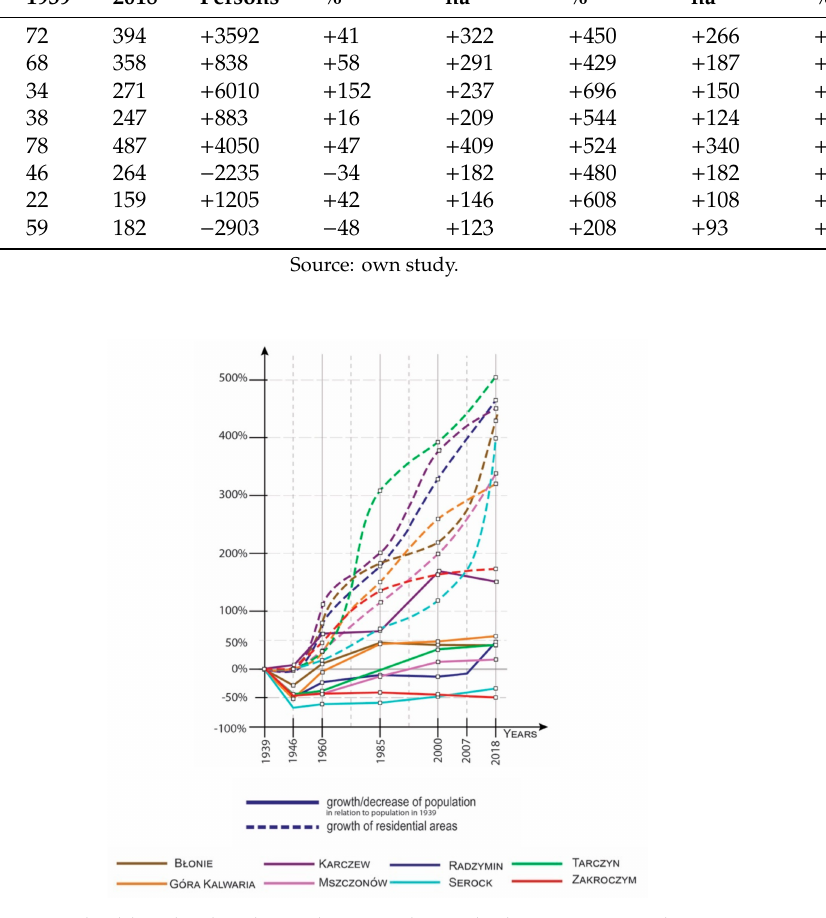
Figure 8. Increase in building land and population in the studied cities compared to 1939. Source: own study based on numerical data for specific time periods according to Figure 9 and Table 4.